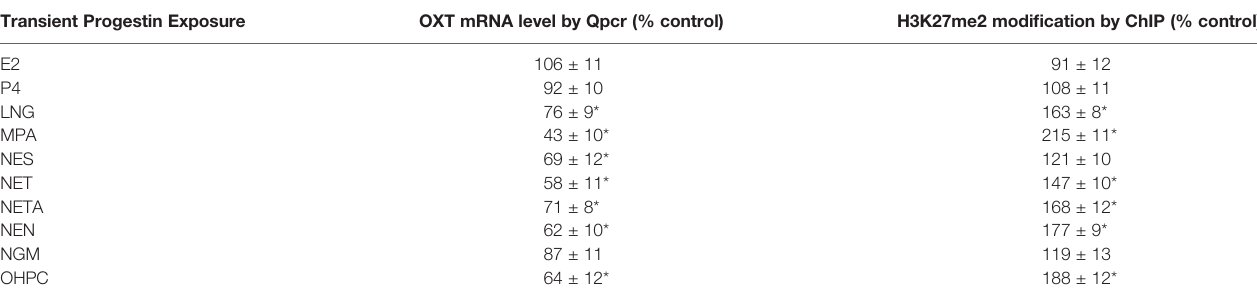
TABLE 1 | Transient progestin exposure causes persistent epigenetic changes on the OXT promoter and the subsequent OXT suppression. Transient Progestin Exposure OXT mRNA level by Qpcr (% control)